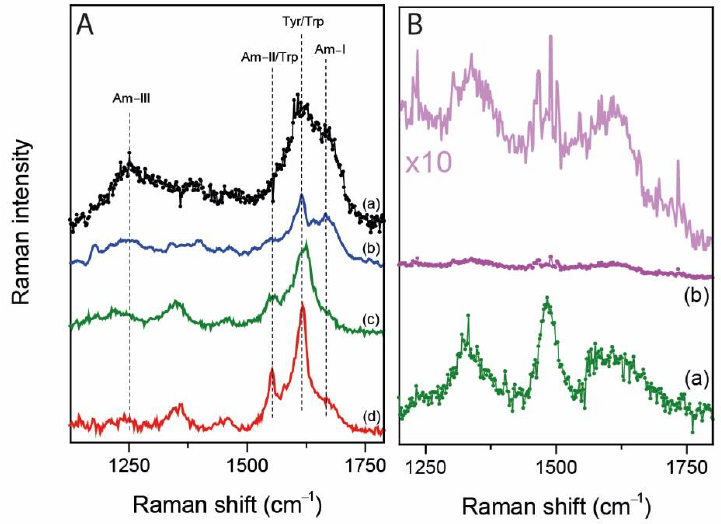
Figure 4. ( A ) ( a ) the 250 nm UVRR spectrum of patient 5 with the pure RNA contribution removed is compared with the previously published 244 nm-UVRR spectra of different proteins such as ( b ) α -synuclein fibrils (unpublished data), ( c ) lysozyme fibrils and ( d ) freshly prepared solution of lysozyme [31]. Typical proteins’ contributions are highlighted with dashed black lines. ( B ) UVRR spectra of patient 3 collected with ( a ) and without ( b ) the presence of the RNAse inhibitor (in green and in magenta, respectively). In order to compare both spectra ( a , b ), the spectrum of ( b ) has been multiplied by a factor 10. Table 2. Estimation of the RNA concentration from model cell lines and from the semen of five patients.